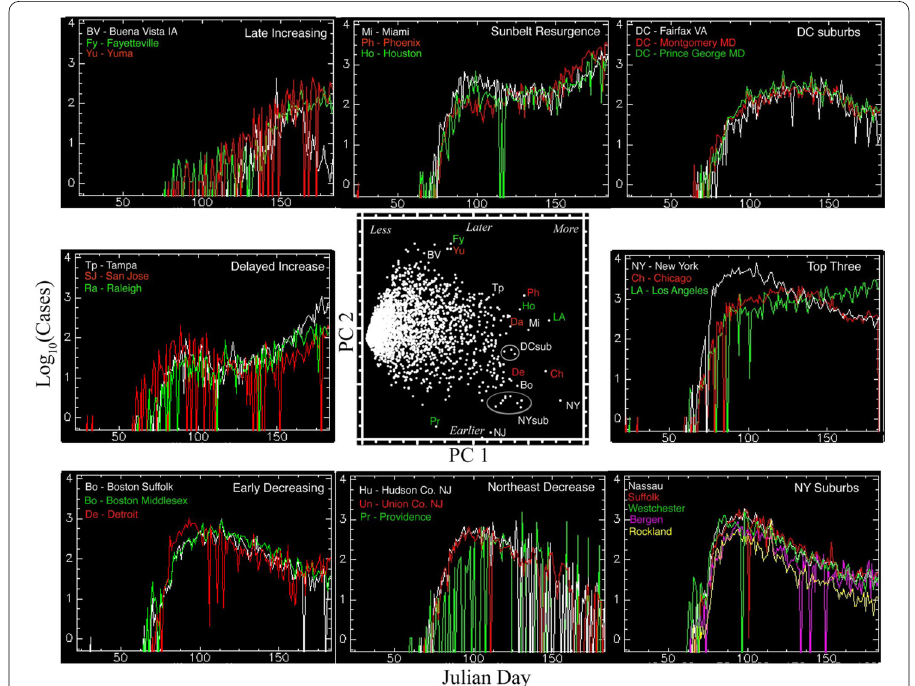
Fig. 12 Spatiotemporal analysis of case trajectories in the USA. The first Principal Component also corresponds to total number of cases, while the second corresponds to timing and trend—distinguishing rapid early onset, later decreasing counties from slower, later onset, continued increasing counties